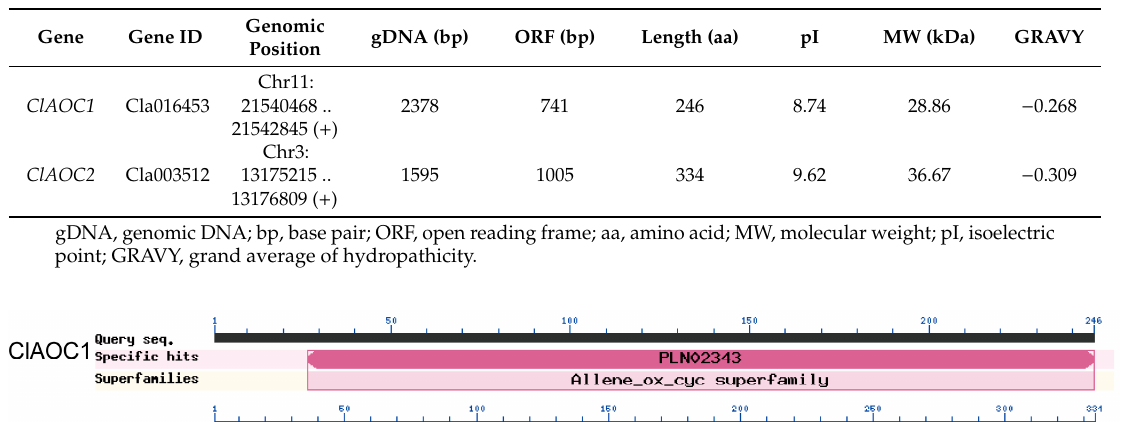
Table 1. The basic characterizations of ClAOC genes in watermelon.